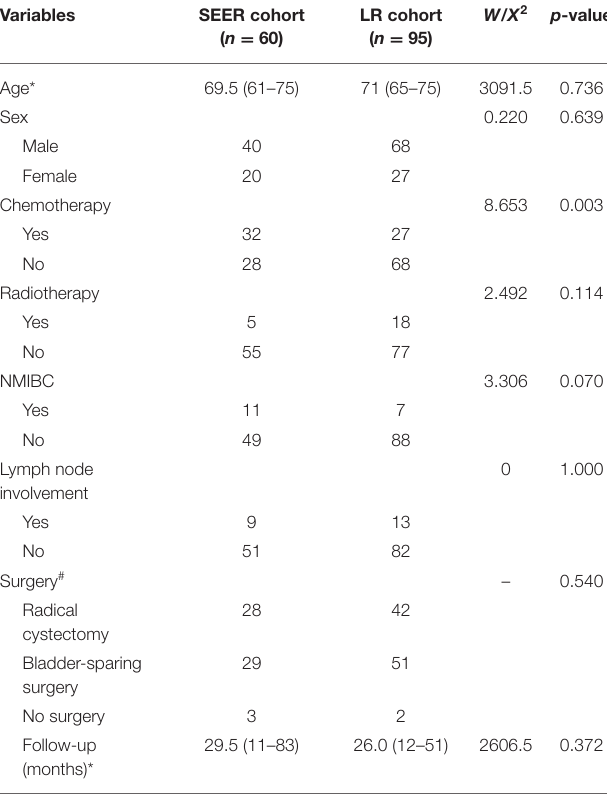
TABLE 1 | Baseline characteristics of patients with LELCB in the SEER database and from literature review.